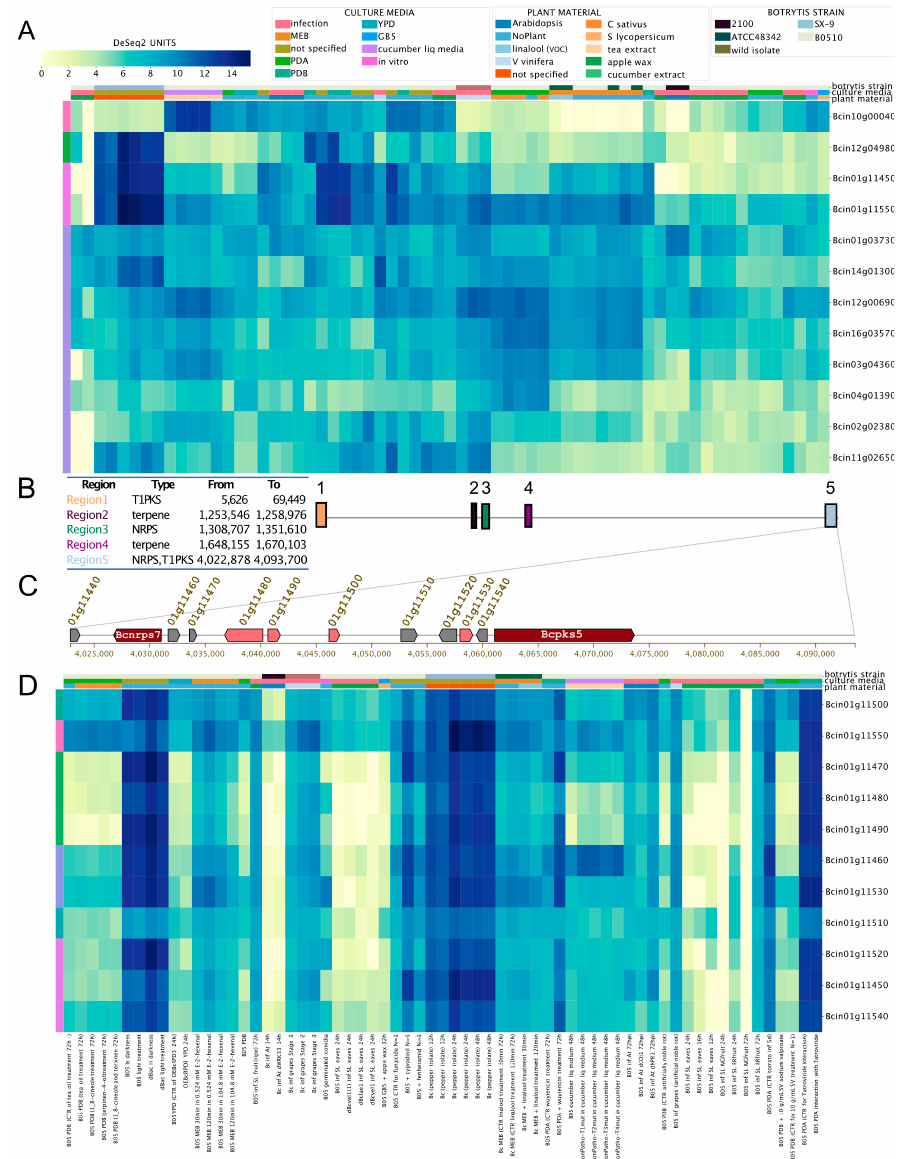
Figure 5. Expression patterns of genes encoding non-ribosomal peptide synthetases (NRPS) and hybrid polyketide synthetases (PKS-NRPS) in B. cinerea . ( A ) Expression patterns of all predicted NRPS and PKS-NRPS mentioned in Supplementary Material 3. To streamline the figure, the description of each experiment was omitted. ( B ) Identification of the five SM gene clusters on B. cinerea chromosome (Chr) 1. The table inset describes each of the five SM regions within Chr1, the predicted SM type, and their respective genomic coordinates. Colored boxes represent each region (right, with numbers). ( C ) Clustered genes within “Region 5” as described in ( B ). Boxes with arrowheads indicate each gene’s transcriptional orientation within the SM gene cluster. Dark red and pink arrowhead boxes indicate core and additional biosynthetic genes, respectively. Grey indicates other genes. Gene IDs and gene names are indicated. For simplicity, the “Bcin” prefix was omitted. ( D ) Expression patterns of all genes encoded in “Region 5” as indicated in ( B , C ), from bcnrps7 to bcpks5 . Both heatmaps indicate mRNA levels and experimental conditions as described in the former figures. In (D), a detailed description of each experiment is provided at the bottom of the heatmap (SRA IDs were not included).